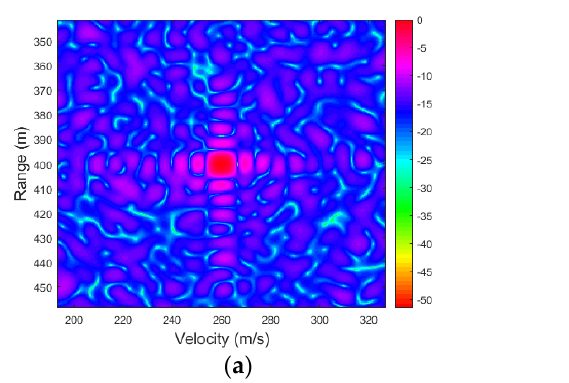
Figure 4. Normalized range-velocity image of a one-point target with R = 400 m and V = 260 m/s, level in dB. ( a ) SDFnT-based method. ( b ) 2D-FFT method.